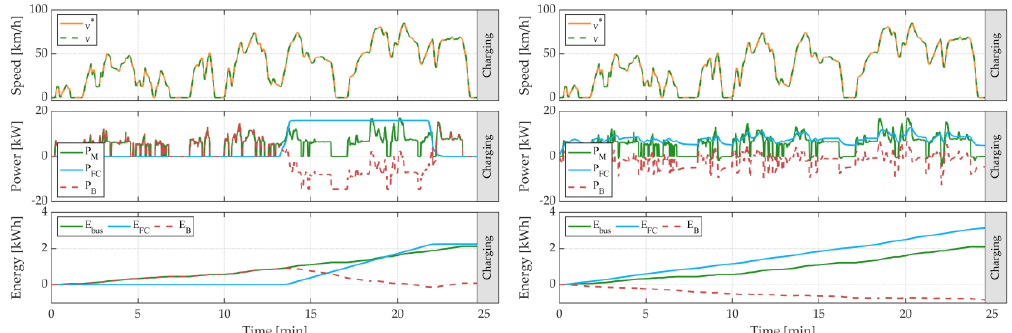
Figure 17. Powers and energies achieved over WLTC by H-EMS ( left ) and S-EMS ( right ). Energies 2019 , 12 , x FOR PEER REVIEW